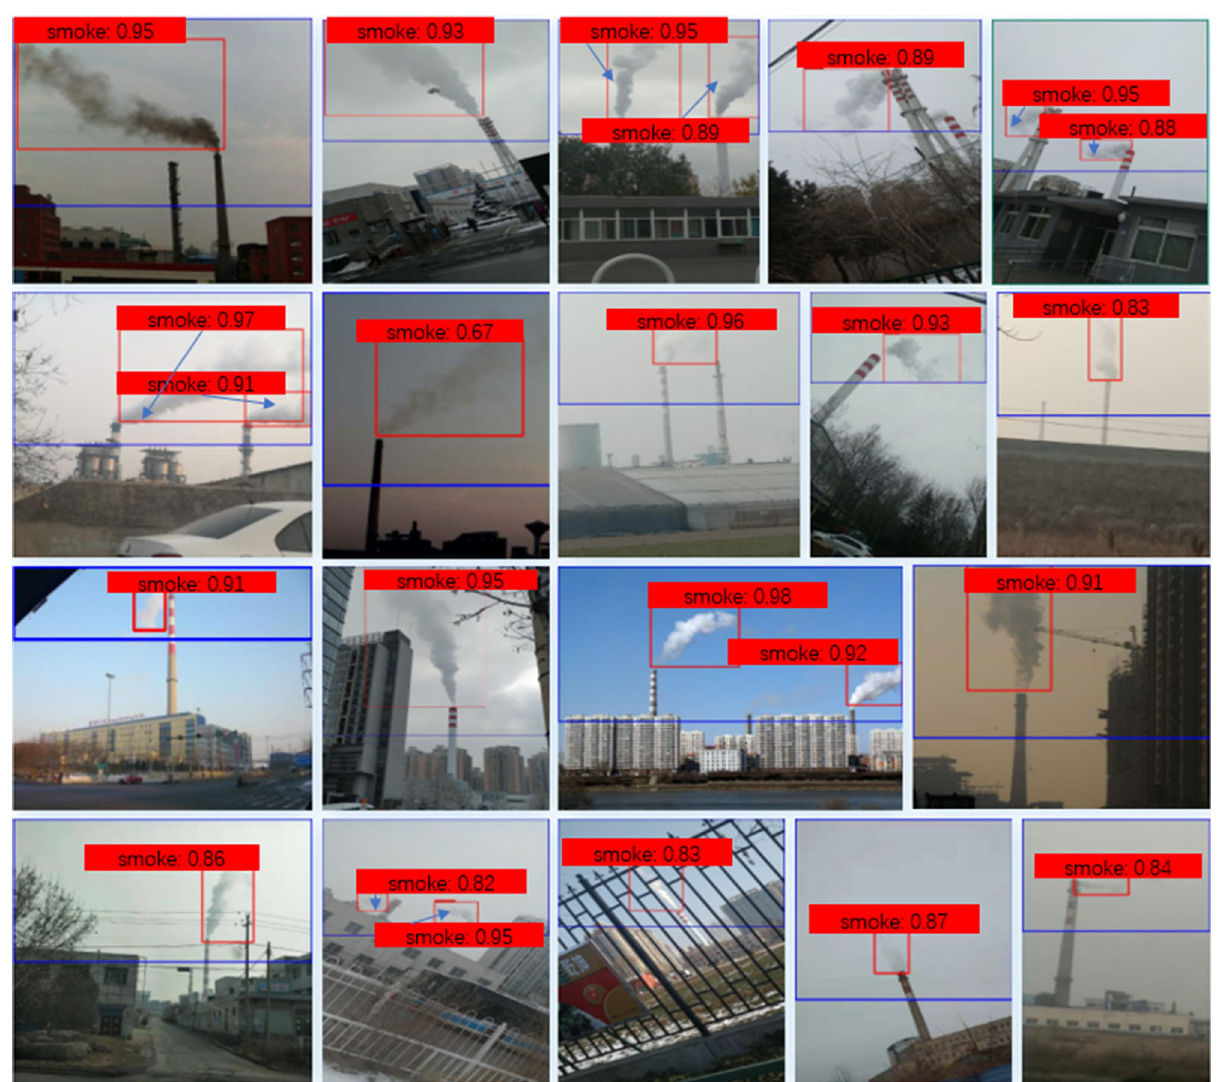
Figure 11. Visual effect of TSSD algorithm on detecting factory smoke.Four-class smoke images of dataset are all included. Blue boxes represent the reduced detection range, and red boxes show the detected smoke region. The text on top of each bounding box represents the confidence of smoke